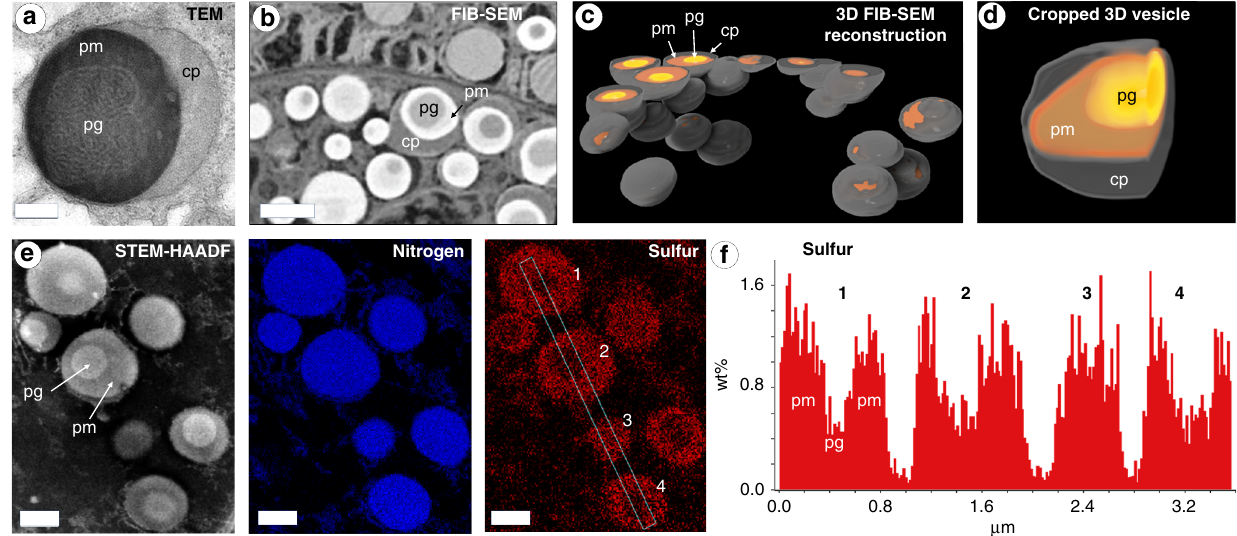
Fig. 2 TEM and FIB-SEM imaging of cuticle secretory vesicles in mussel foot tissue. a TEM image of osmium stained cuticle secretory vesicle from region similar to Fig. 1d. Contrast is achieved by different osmium staining with the proto-matrix (pm) staining the heaviest, the crescent phase (cp) staining the lightest and the proto-granules (pg) staining in between. Scale bar = 200 nm. b FIB-SEM image of osmium stained region of cuticle gland similar to Fig. 1d. Contrast is inverted compared to TEM, but pg, pm and cp can clearly be differentiated. Scale bar = 1000 nm. c Using electron density contrast, secretory vesicles and their inner structure were reconstructed in 3D from an image stack consisting of 392 images. d Magni fi ed and cropped 3D image of a cuticle secretory vesicle showing all three phases. e STEM-EDS compositional analysis of native cuticle granule and matrix regions, showing distribution of nitrogen and sulfur in the region in the STEM-HAADF image in the left panel. Scale bar = 500 nm. f Relative sulfur wt% (not calibrated) collected from a transect across four secretory vesicles in dotted box in e reveals that pg has approximately one half the amount of sulfur as